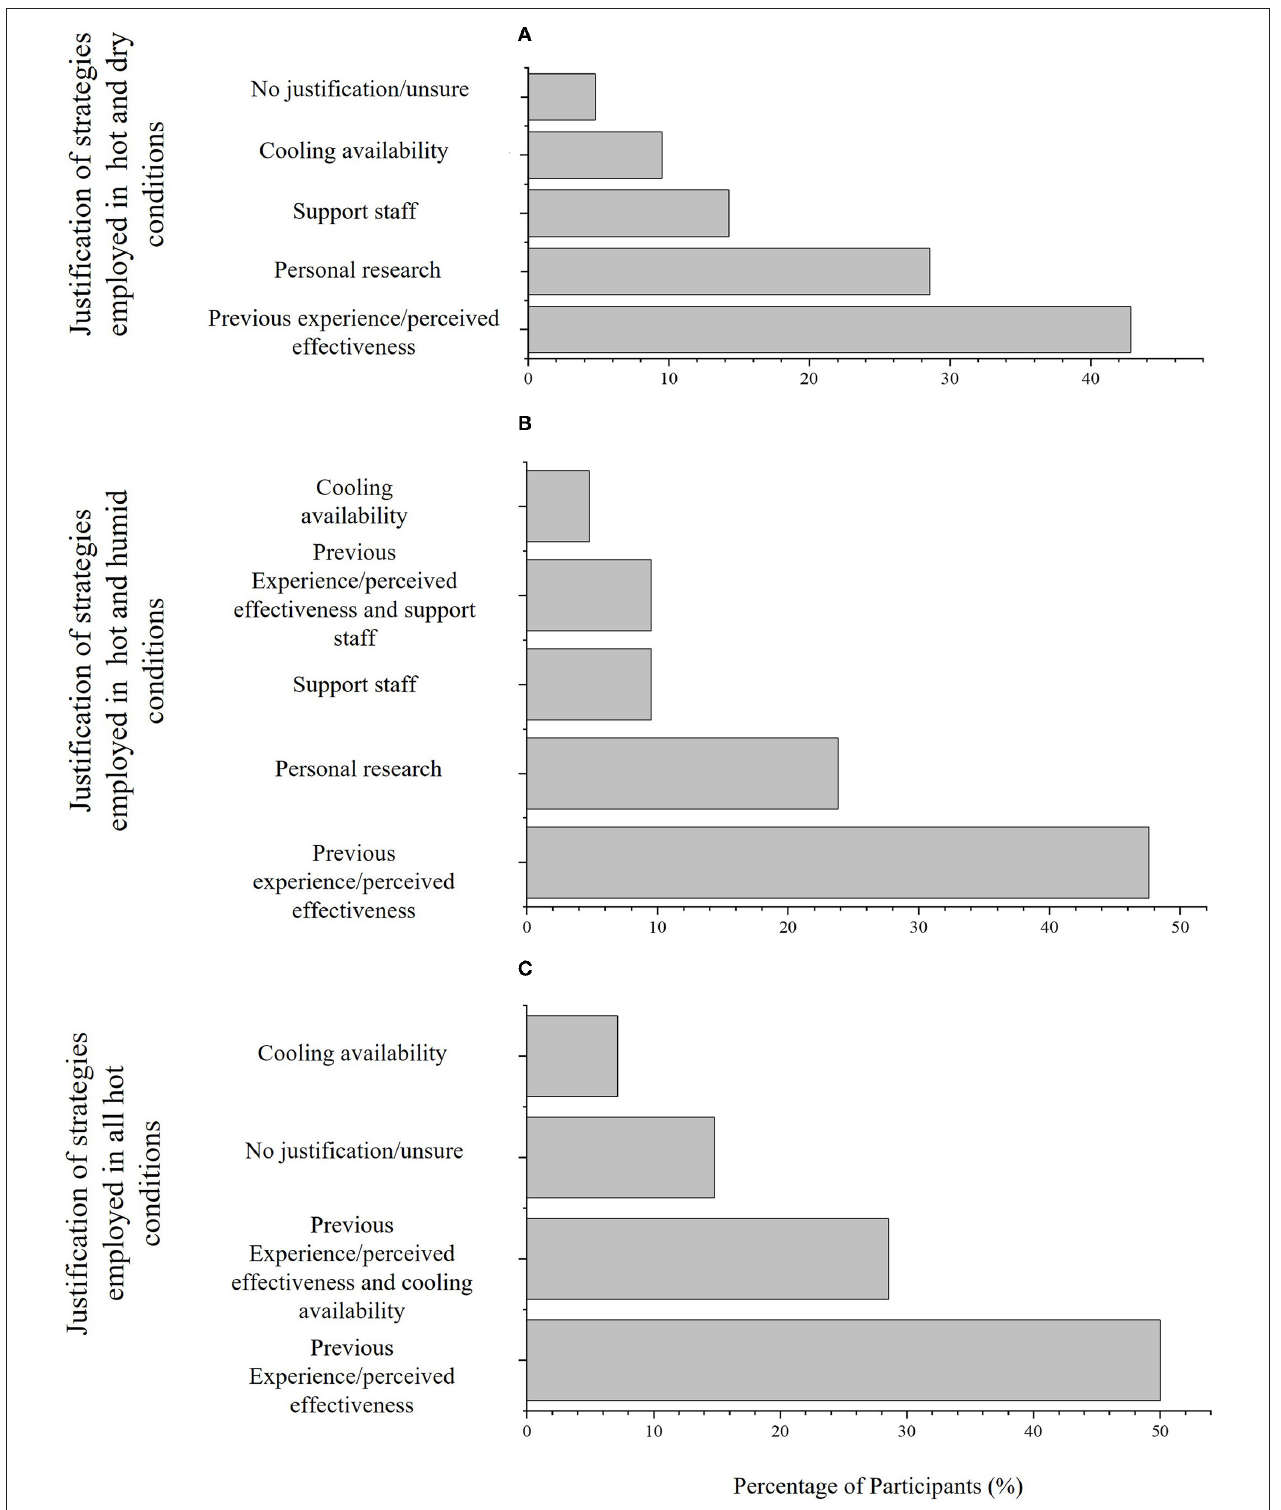
FIGURE 5 | (A) How the type and timing of strategies employed in hot and dry conditions by 60% ( N = 21) participants who use different strategies depending on condition were established, (B) how the type and timing of strategies employed in hot and humid conditions by 60% ( N = 21) participants who use different strategies depending on condition were established, and (C) how the type and timing of strategies employed in in all hot conditions by 40% ( N = 14) participants who employed the same strategy regardless of condition were established.